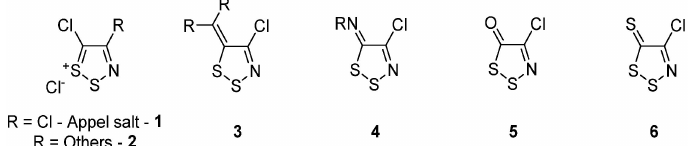
Figure 1. Appel salt ( 1 ) and other general 1,2,3-dithazoles structures 2 – 6